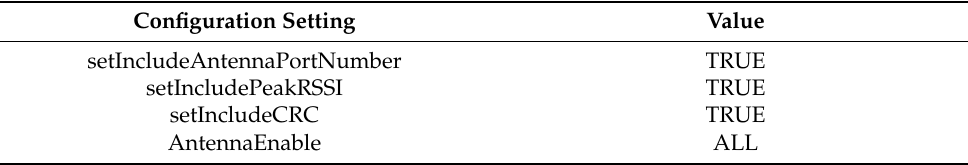
Table 2. Impinj xArray antenna configuration.